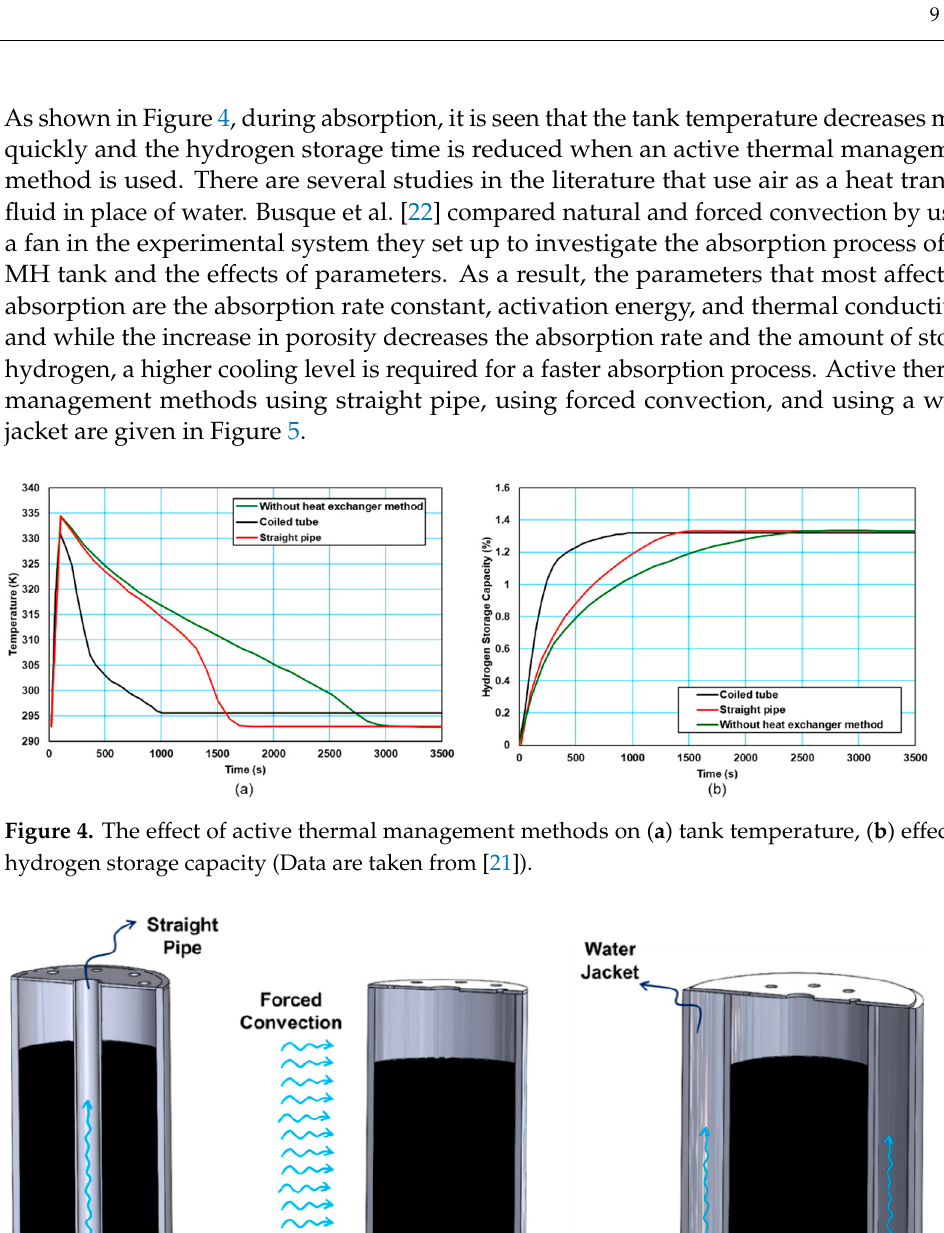
for the following cases: (i) the system was only in natural convection, (ii) only the cooling